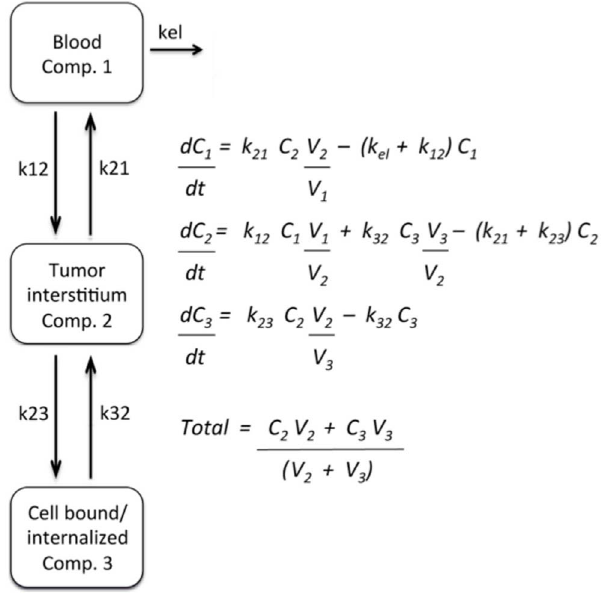
Figure 8. 3-compartment model and equations that were employed to fit the experimental data. k is constant, C is concentration (nM) and V is volume (L).